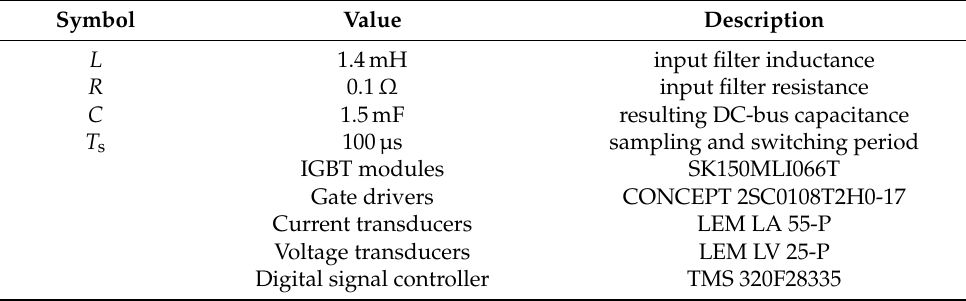
Table 3. Parameters and main components of the laboratory